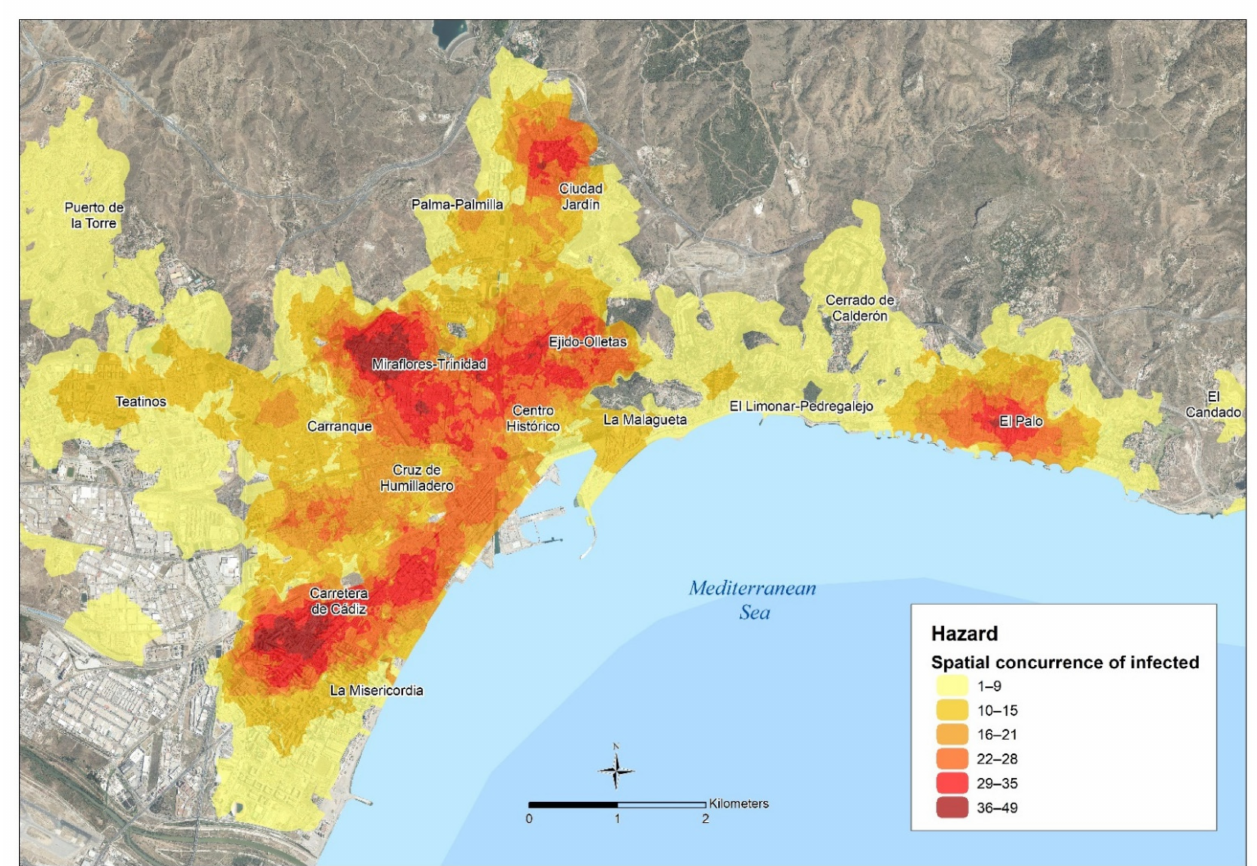
Figure 6. Map of maximum transit areas of potential infected